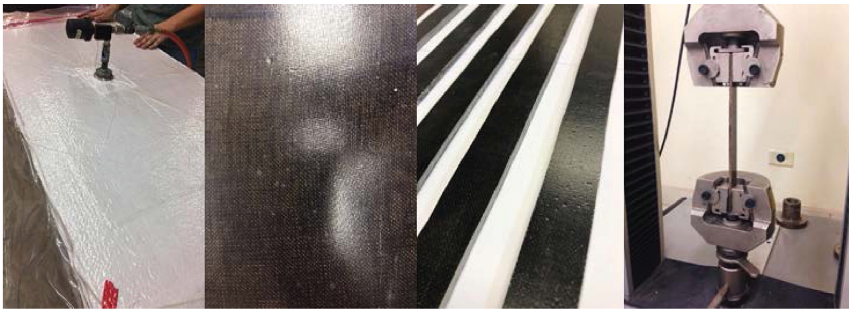
Figure 1: Fabrication and testing of composite materials for a wind turbine blade. Table 2: Material properties of the composite characterization of basalt/epoxy (B-E) and E-glass/epoxy (EG-E). Properties